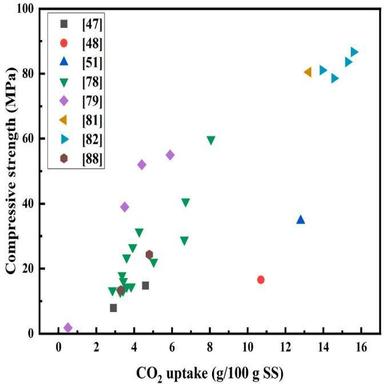
The compressive strength of the SS compact under different CO2 uptake.